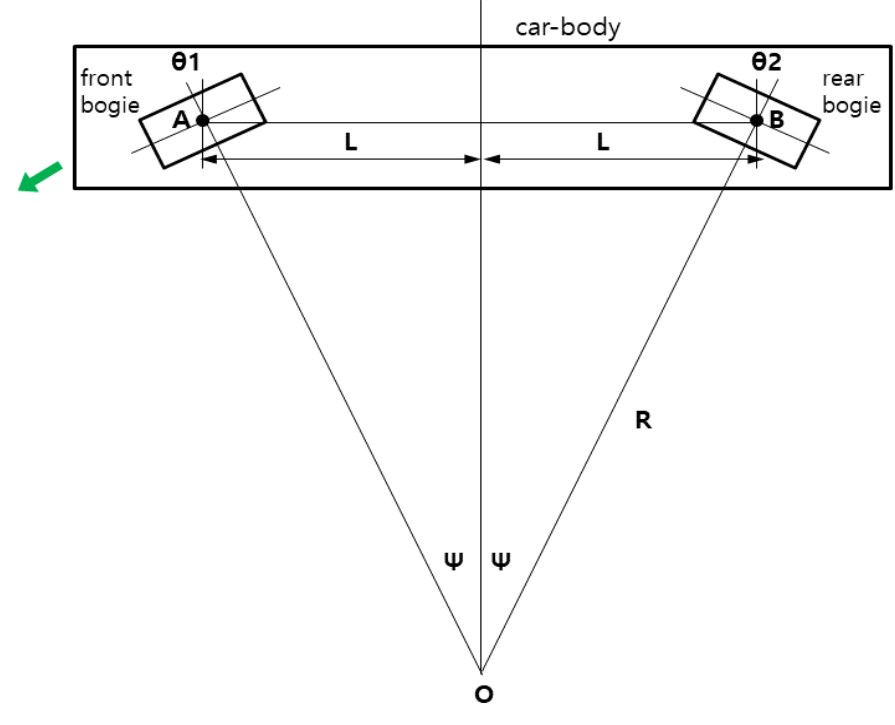
Figure 2. Position of car body and bogies in a curved section.